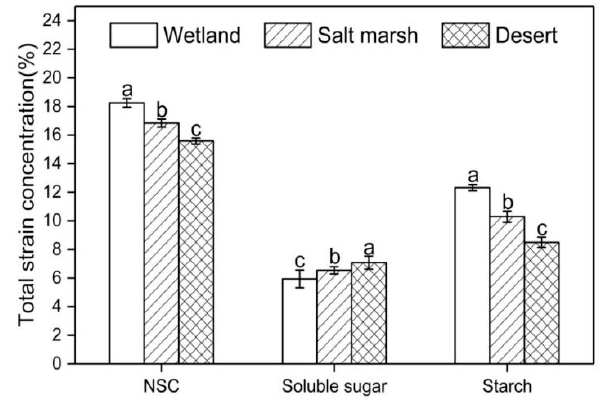
Figure 3. Comparison of NSC and their component (soluble sugar and starch) contents in Phragmites communis from different habitats (Error bars represent standard deviation; different lowercase letters indicate significance among different habitats at p < 0.05 level).